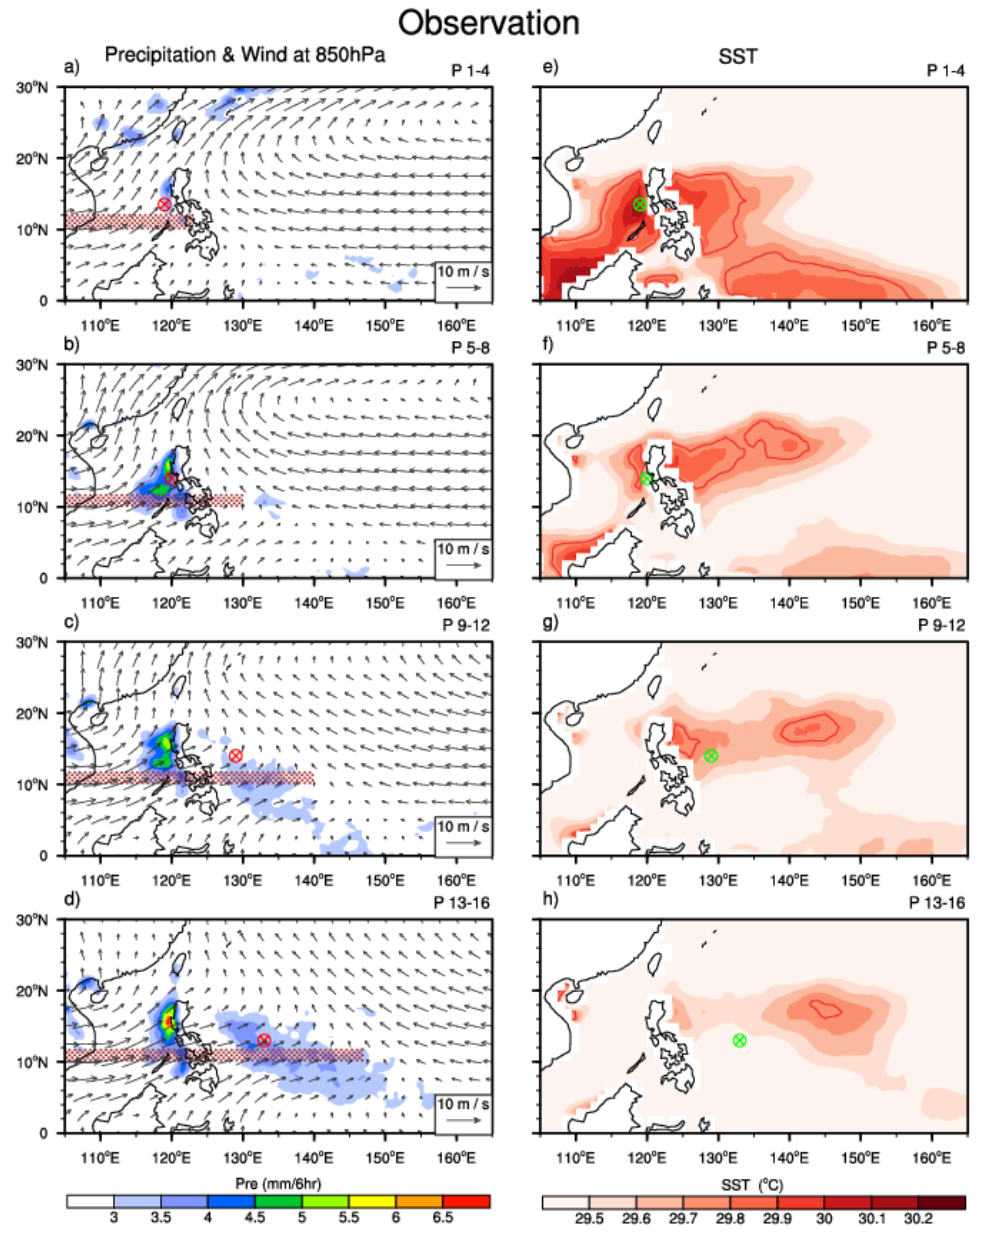
Figure 2. ( a – d ) Horizontal evolution (4 pentad mean) patterns of the precipitation (shading; mm/6 h) and wind field (vector; ms − 1 ) at 850 hPa. The red straps show the eastward-extended low-level westerly. ( e – h ) Horizontal evolution patterns of SST (shading; ◦ C). The interval is 0.1 ◦ C. The red contour = 29.75 ◦ C. The red and green circles in both the left and right panels denote the eastward-extending MT rainfall centers. Data are derived from ERA-interim and TRMM for a 20-year period ( 1998 – 2017) .